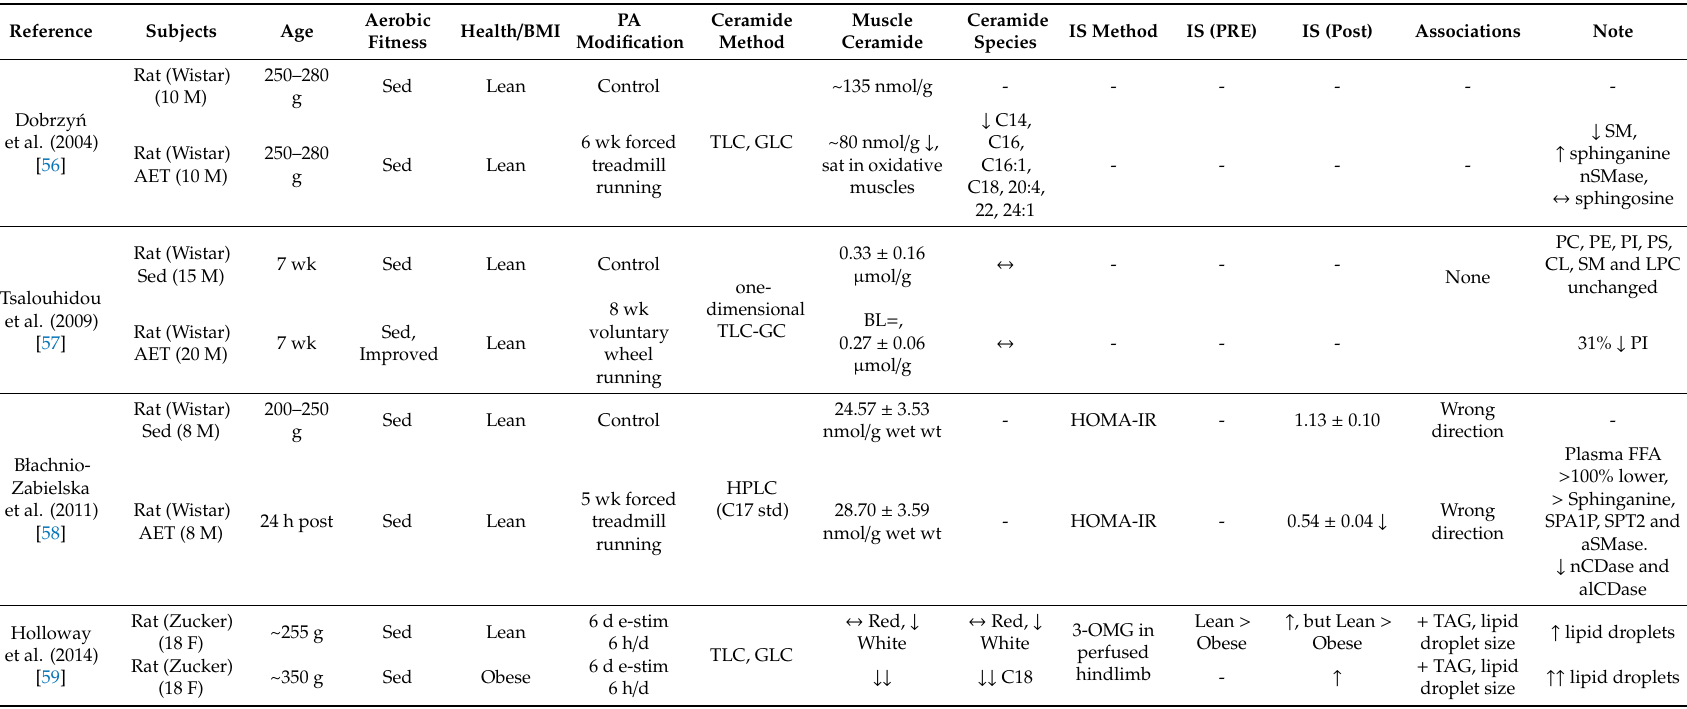
Table 2. Exercise training studies in